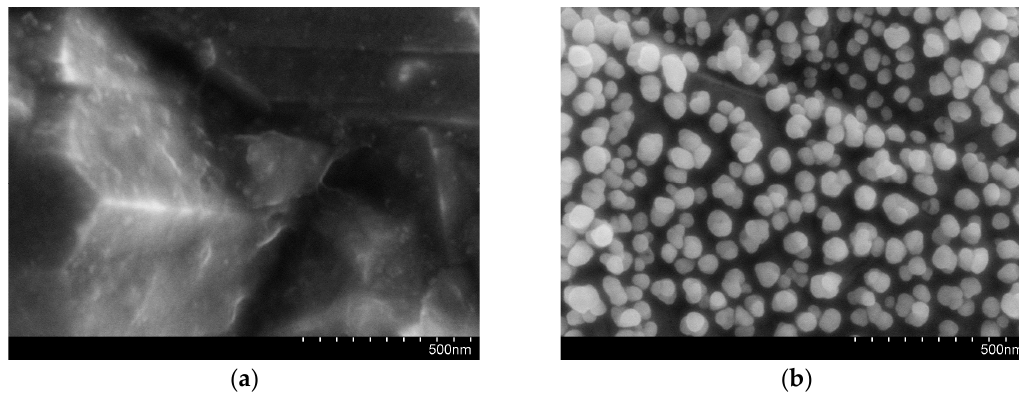
Figure 3. The SEM images of the BDD electrode before ( a ) and after ( b ) AuNPs deposition.